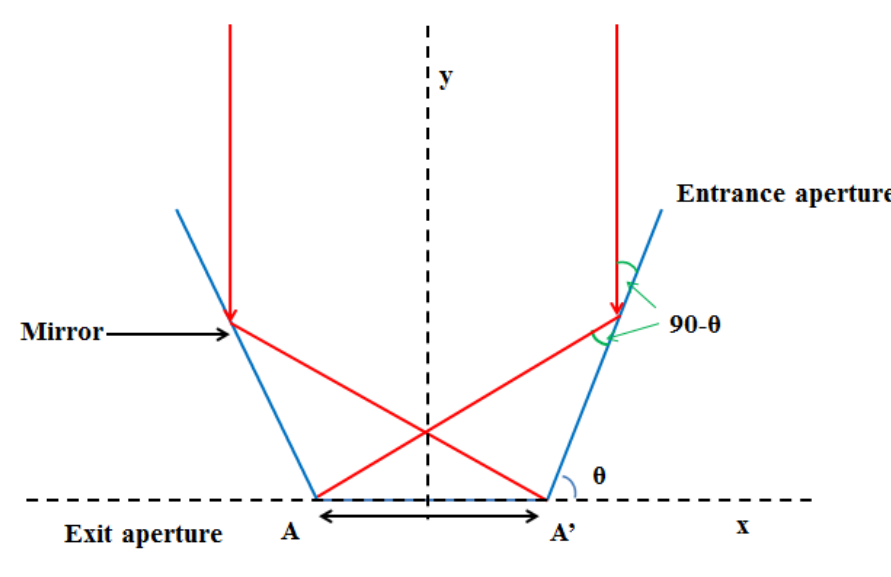
Figure 25. Conical concentrator design proposed by Kiatgamolchai et al. [40].